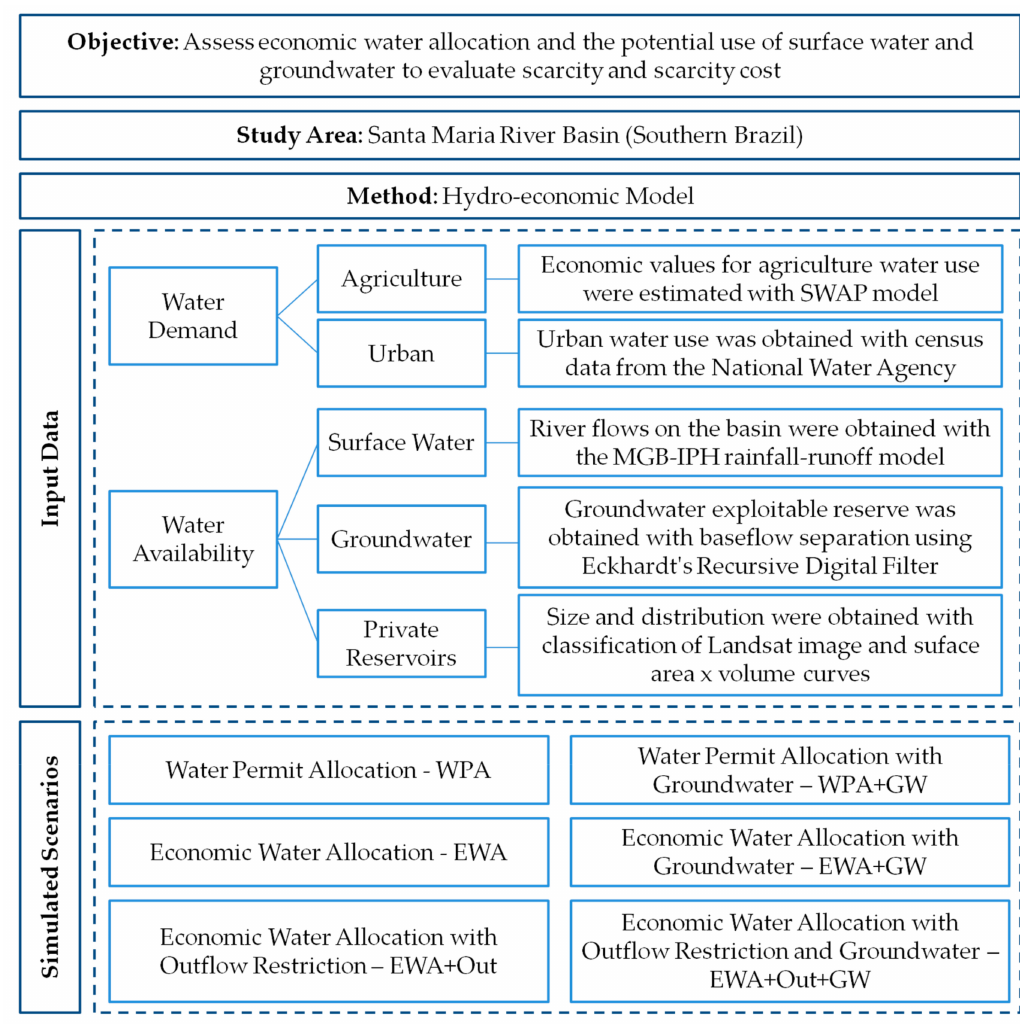
Figure 1. Workflow of the hydro-economic model input data and simulated